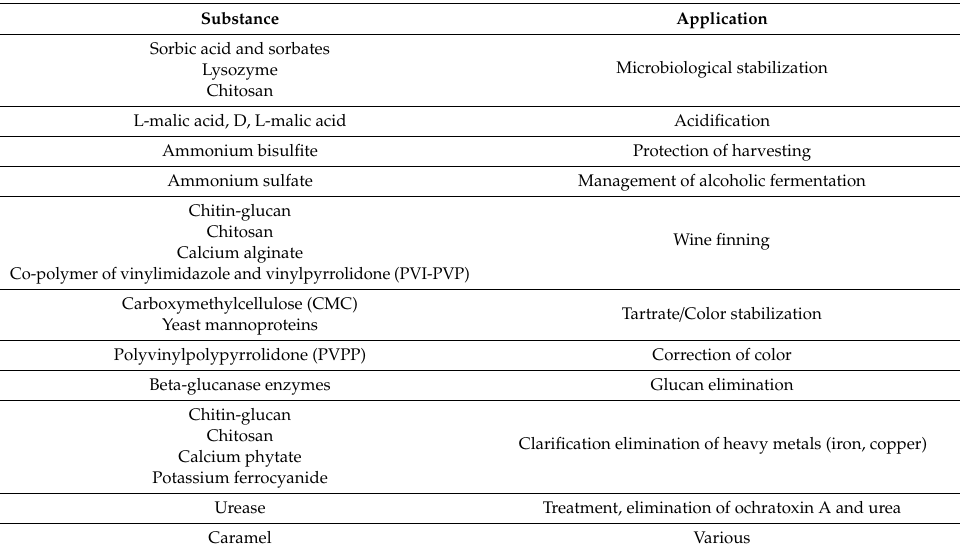
Table 2. List of substances forbidden in organic wines production